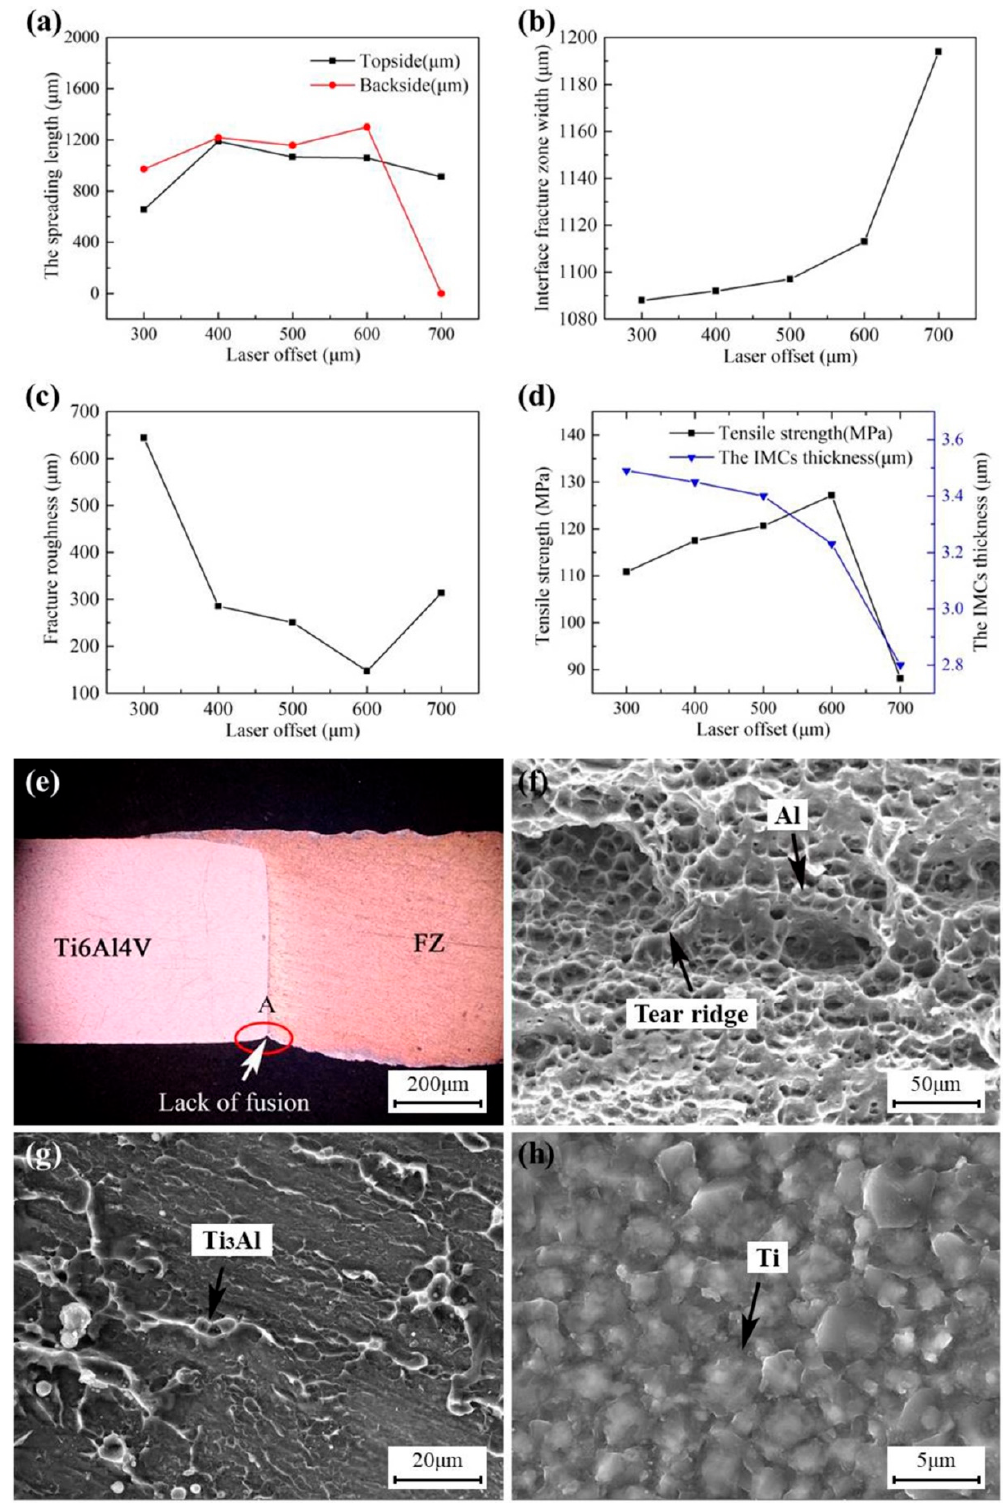
Figure 6. Influence of laser offset on the joint properties: ( a ) the spreading length; ( b ) interface fracture zone width; ( c ) fracture roughness; ( d ) tensile strength and the IMC thickness, and cross section and details of the fracture of Joint #5: ( e ) cross section of the joint; ( f–h ) details of Areas A, B, and C in Figure 4a, respectively.